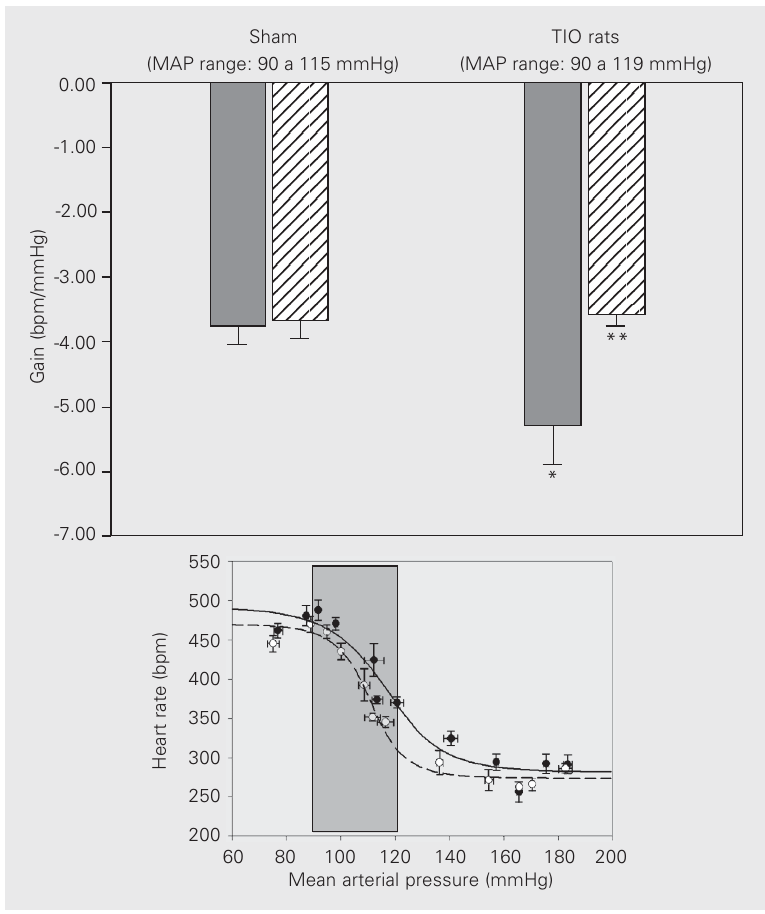
Figure 4. General baroreflex gain elicited before (filled bar) and after (hatched bar) deferox- amine infusion (20 mg/kg, over 20 min). Left bars indicate sham rats and right bars indicate tissue iron overload (TIO) rats. The bottom panel is a copy of Figure 3B with the marked area showing the linear region of the baroreflex curve in which baroreflex was tested in the deferoxamine experiment. *P < 0.05 compared to the sham group; **P < 0.05 compared to the TIO rats before deferoxamine infusion (Student t -test).